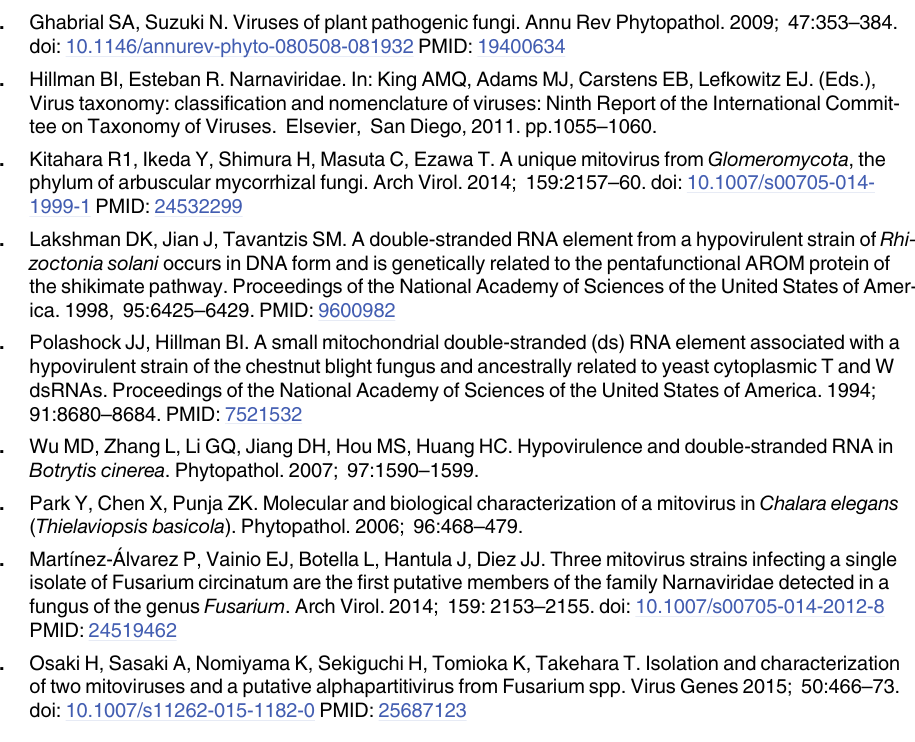
S1 Table. Summary of information for fungi known to host mycoviruses. S2 Table. Primers used for investigation of Cronartium ribicola mitoviruses. S3 Table. RNA-Seq read count and relative coverage of Cronartium ribicola